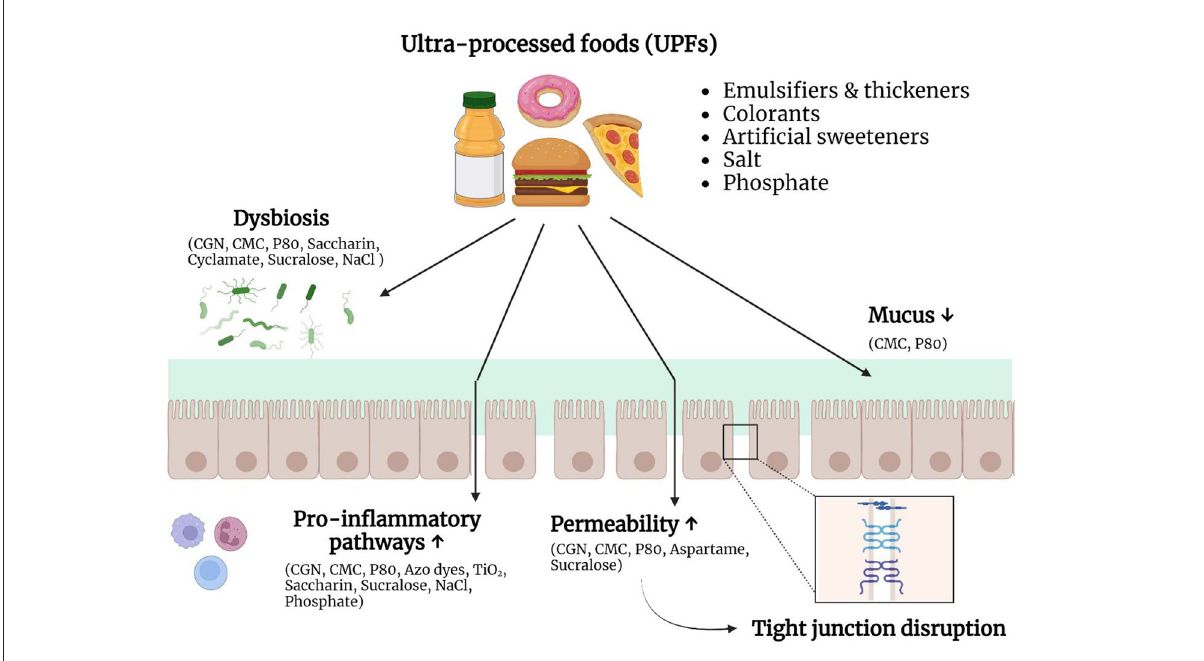
FIGURE1 Non-nutritive ingredients and additives in ultra-processed foods (UPFs) can negatively affect the intestinal barrier. UPFs typically consist of a combination of substances derived from foods and food additives. Growing evidence suggests that these non-nutritive ingredients and food additives are able to interact with the intestinal barrier and therefore play a role in the pathogenesis of IBD. Different food additives can induce dysbiosis, stimulate pro-inflammatory pathways, increase the epithelial permeability, or alter the mucus layer. Due to these changes, the immune system encounters an increased bacterial exposure, which can result in chronic intestinal inflammation. CGN, carrageenan; CMC, carboxymethylcellulose; P80, polysorbate-80; NaCl, sodium chloride; TiO 2 , titanium dioxide. Created with